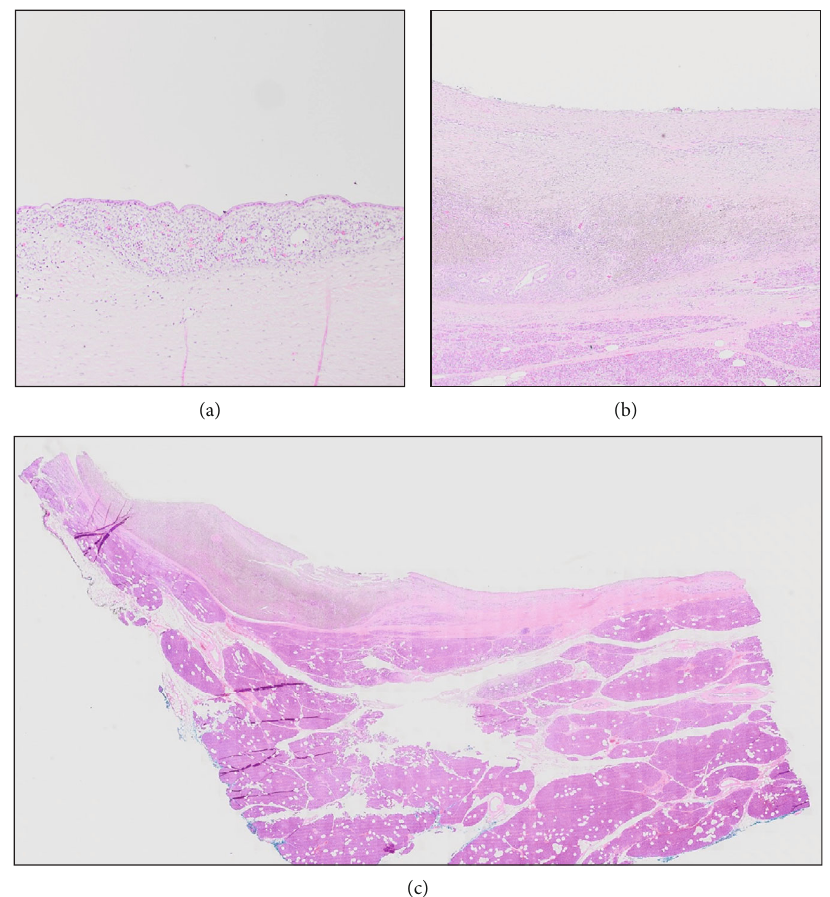
Figure 2: Areas of the cyst are lined by endometrial epithelium and stroma (a), while other areas are denuded but have hemosiderin-laden macrophages underlying the cyst cavity (b). The low power image (c) shows the cyst compressing the surrounding pancreatic